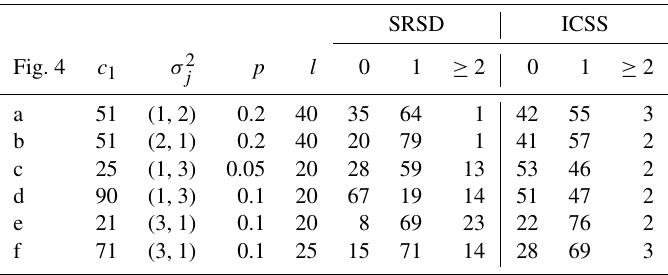
Figure 3. Frequency distributions of change points detected by SRSD (0.1, l , 2) with three different values of l : 20, 30, and 40. The true change points are c j = (31 , 61), and regime variances are (a) σ 2 Table 3. Percentages of total numbers of change points detected by SRSD ( p , l , 2) and ICSS in each series on average in the case of one true change point. The corresponding frequency distributions of the detected change points are presented in Fig.